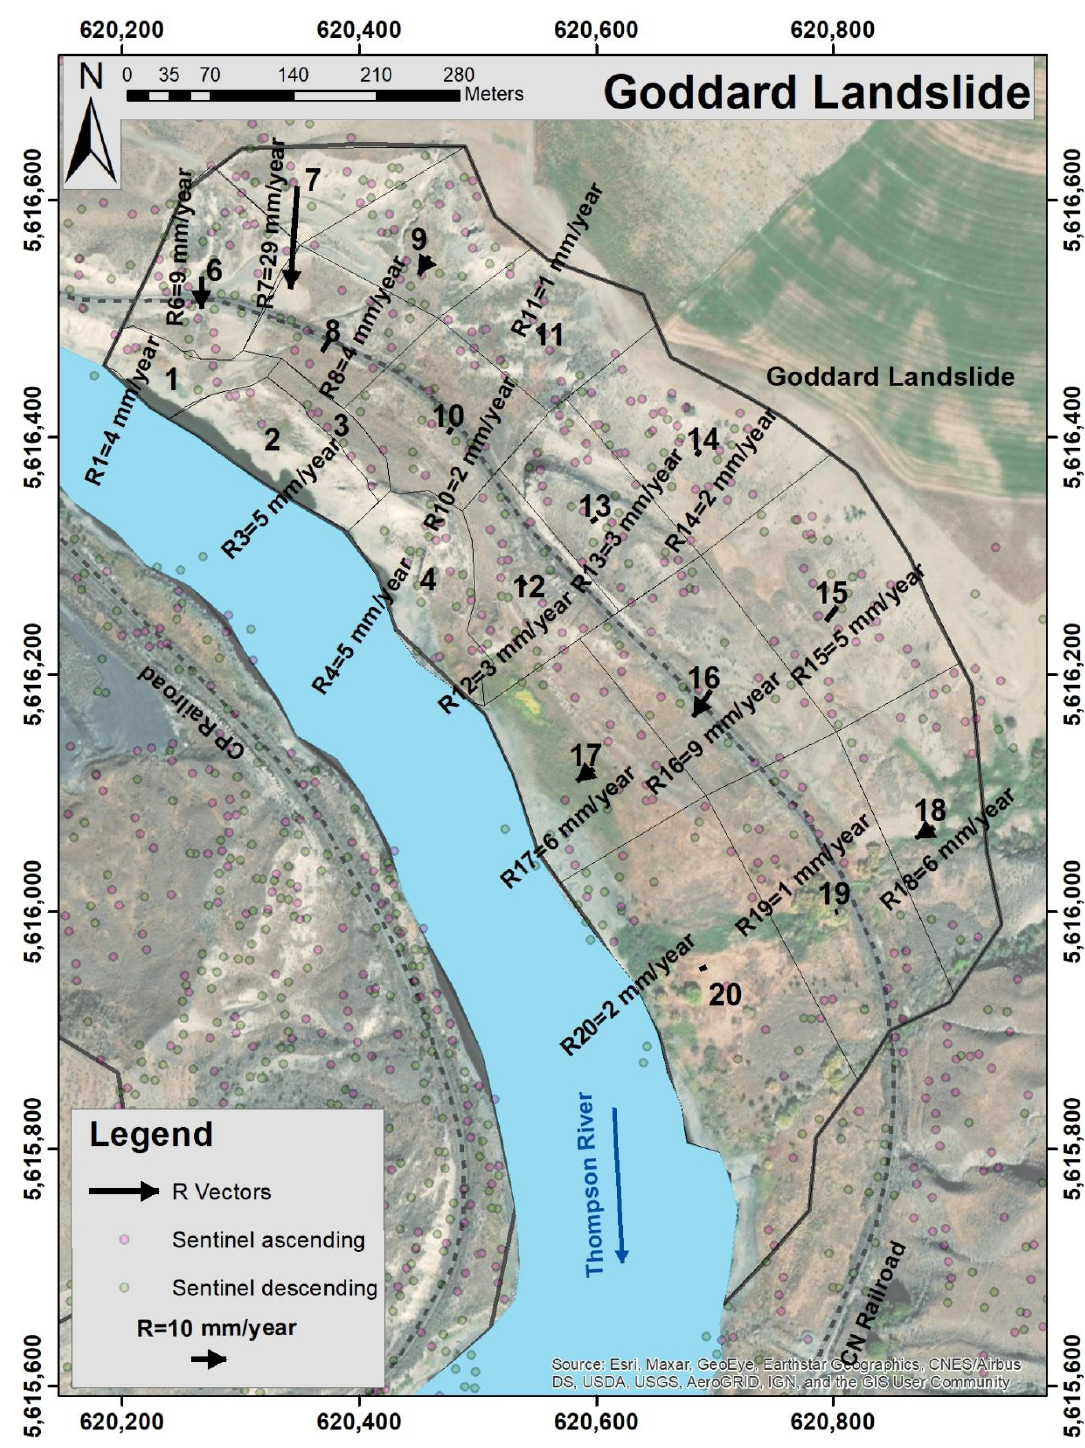
Figure 6. Calculated horizontal component of R vectors for divided parts within the Goddard landslide extent in plan-view.